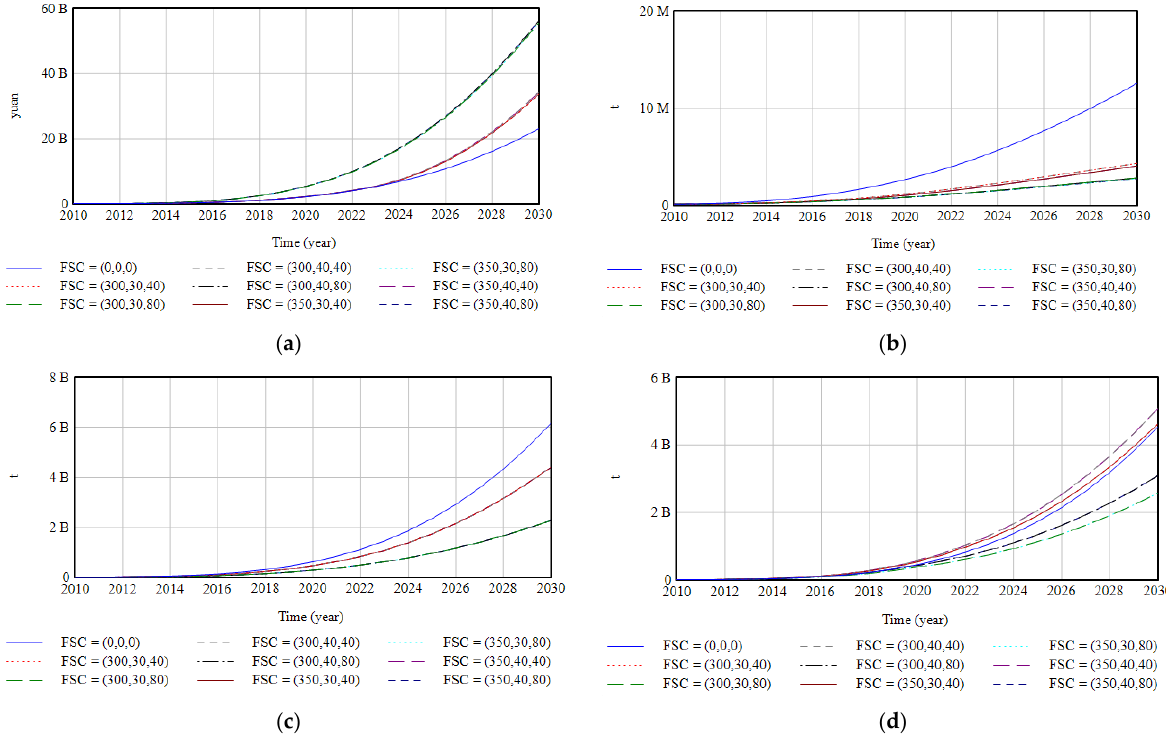
Figure 9. Portfolio policy analysis. ( a ) Environmental benefit. ( b ) Total illegal dumping. ( c ) Total landfill. ( d ) Total Recycling. Table 5. The impact of portfolio policy on major variables.